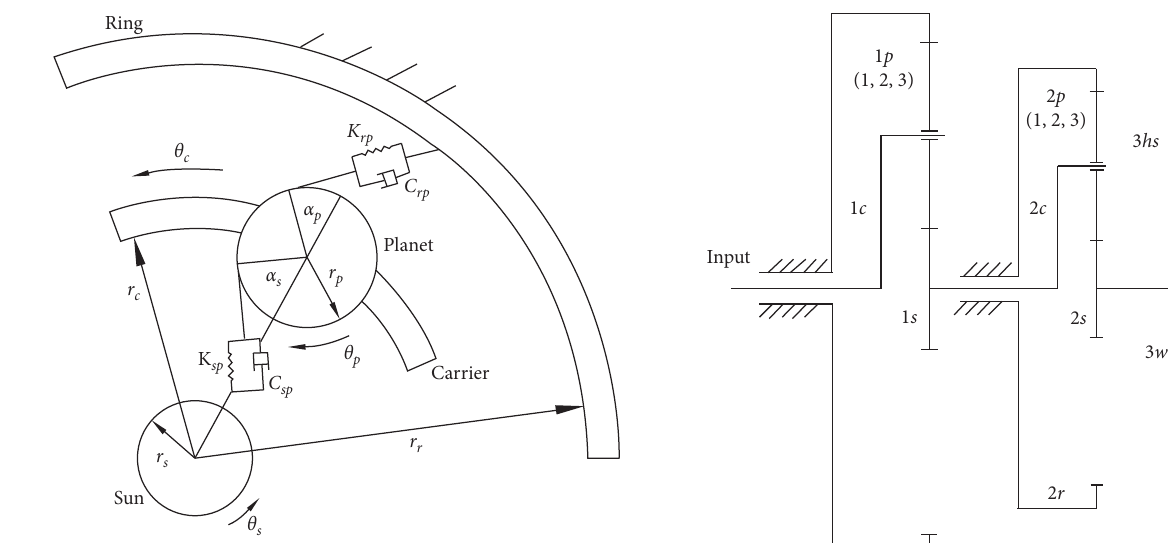
Figure 1: Position of the acceleration sensor and modelling logic of the simulation.